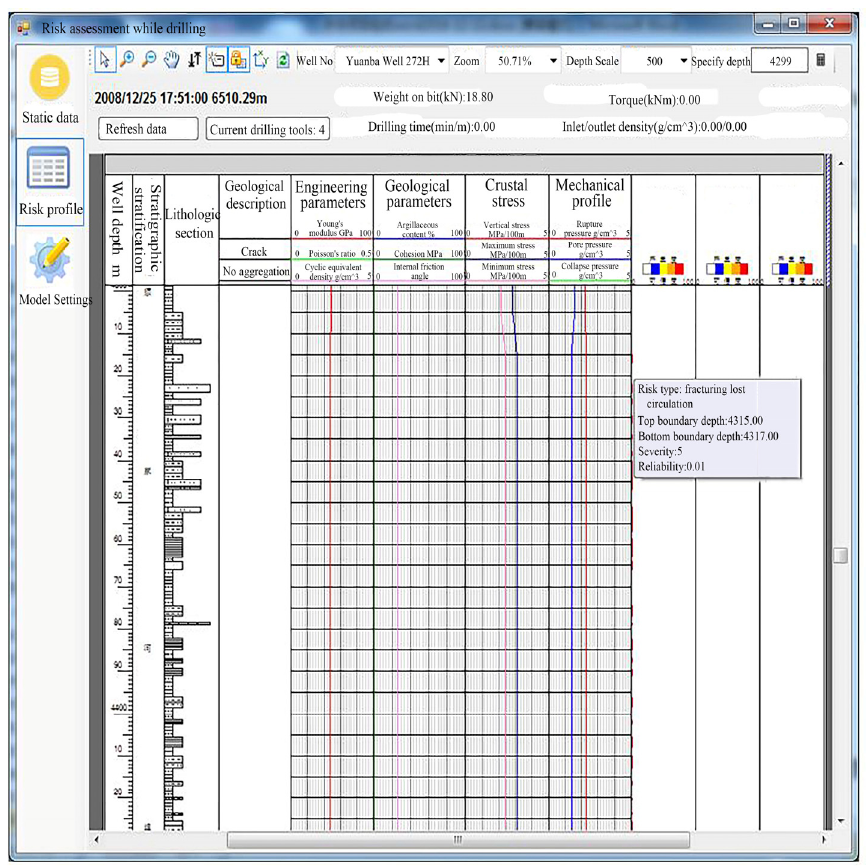
Figure 9. Lost circulation prediction results of Yuanba 272H well.